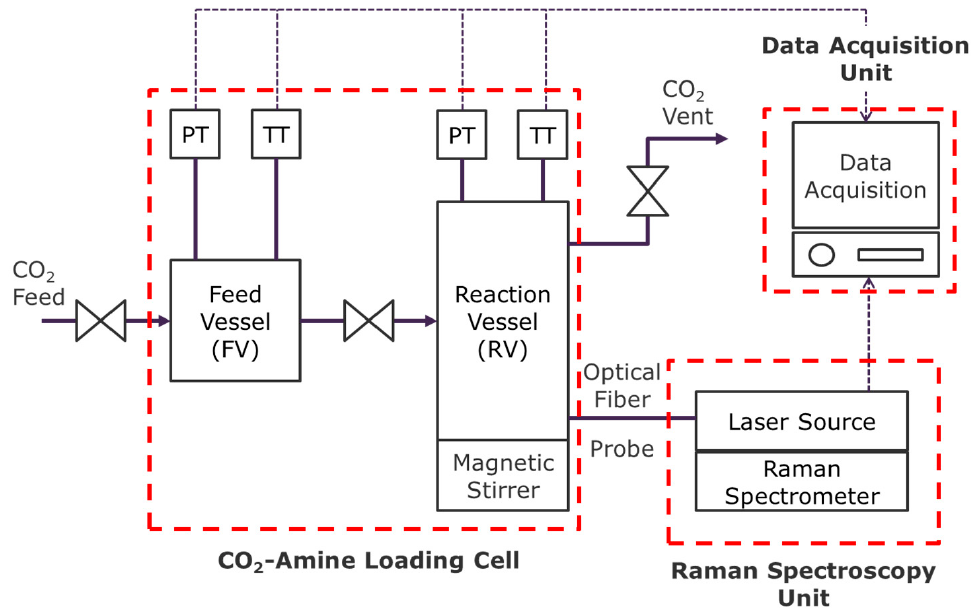
Figure 1. Experimental setup to collect vapour ‐ liquid equilibrium (VLE) data and Raman spec ‐